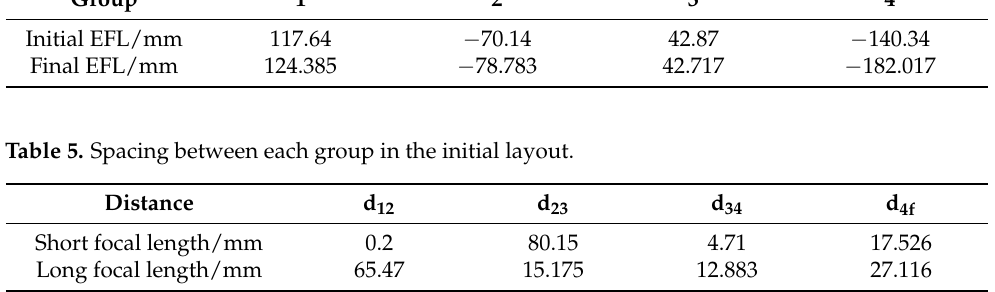
Table 4. Focal length of the four groups. Group